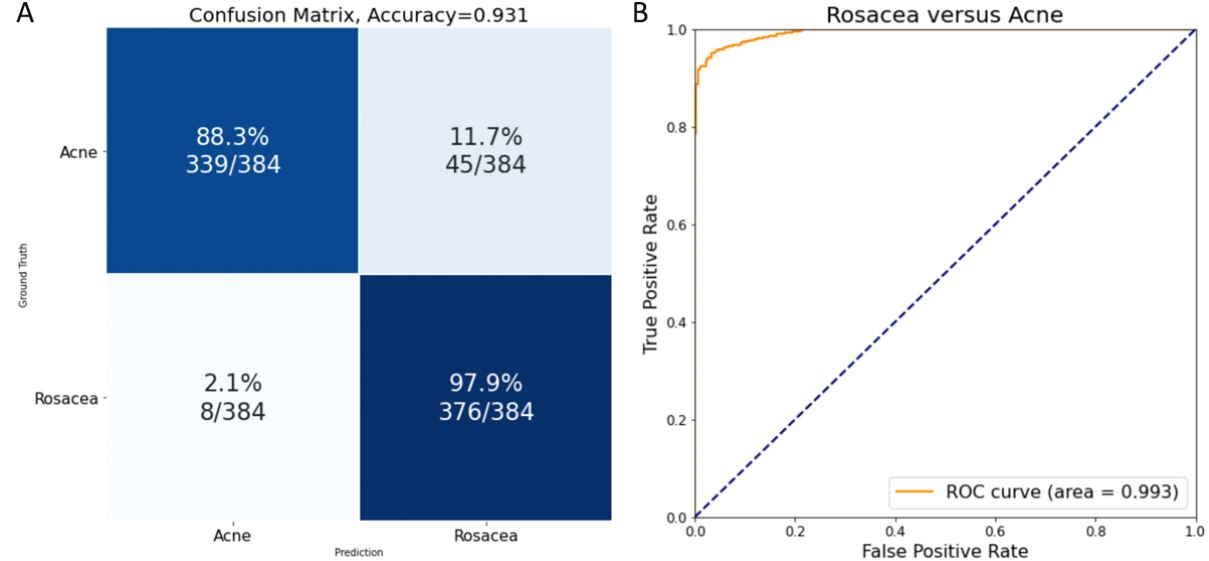
Figure 3. Performance of the convolutional neural network in the identification of rosacea and acne. A. Confusion matrix showing that the accuracy and precision were 0.931 and 0.893, respectively; B. Receiver operating characteristic curve showing that the area under the receiver operating characteristic curve reaches 0.993.